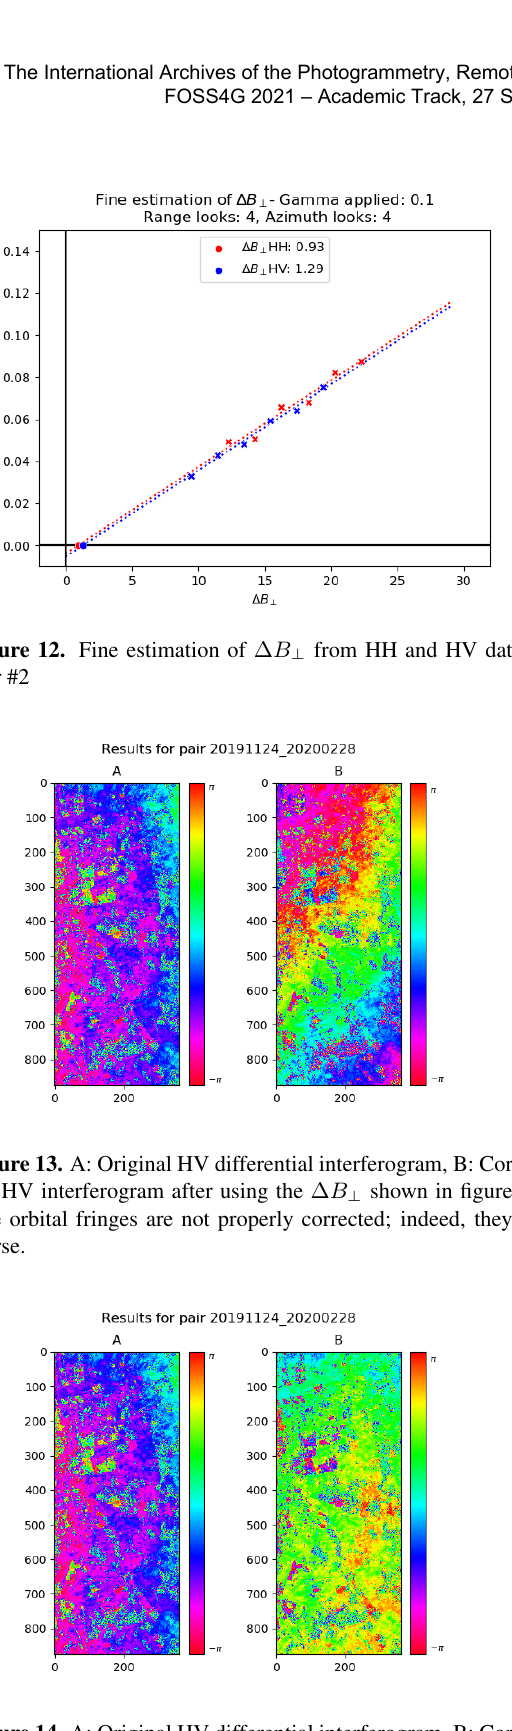
Figure 14. A: Original HV differential interferogram, B: Correc- ted HV interferogram after using the ∆ B ⊥ shown in figure 12. The correction in this case seems to have improved significantly.